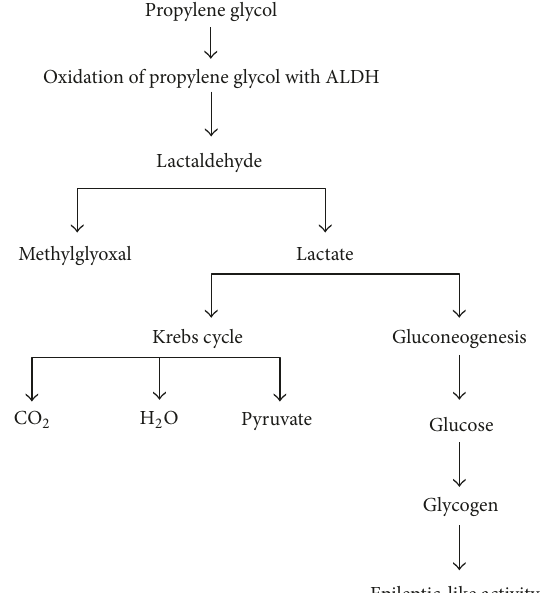
Figure 1: Simplified chart for the metabolism of monopropylene glycol (MPG). Oxidation of propylene glycol by alcohol dehydro- genase (ALDH) leads to primarily lactate production. Epileptic-like activity results if the lactate goes into gluconeogenesis, and astro- cytes convert the glucose into glycogen (adapted and summarized from [5,